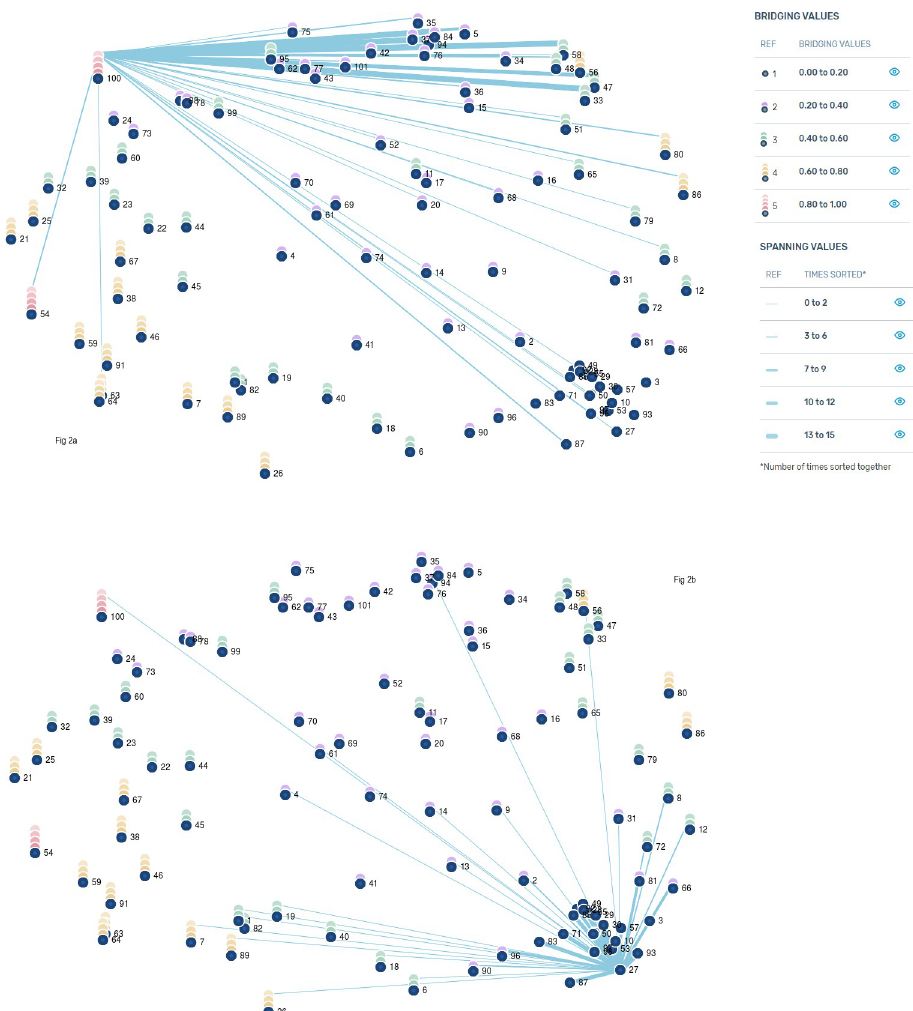
Fig 2. Bridging values for